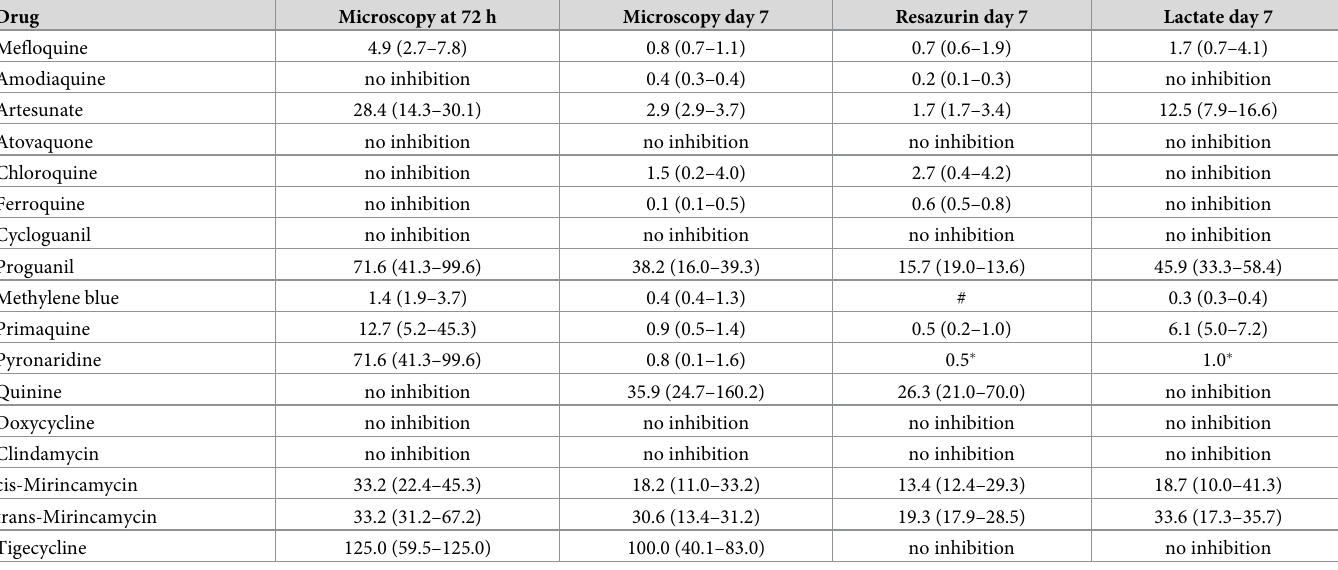
Table 1. Assay-dependent IC50s of compounds against schistosomula (step